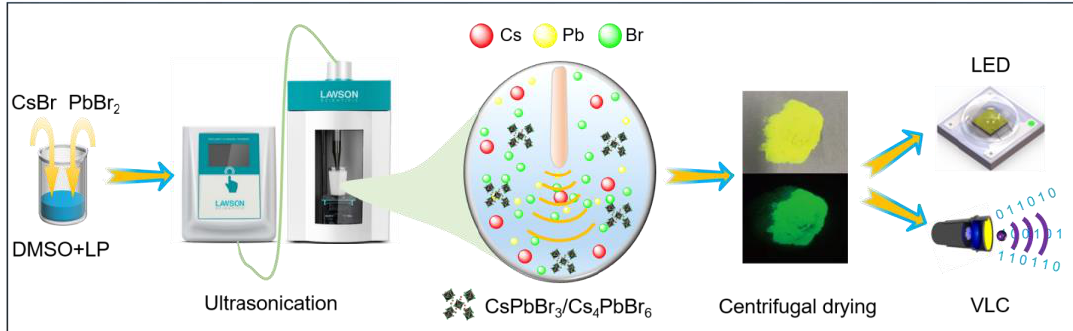
Figure 1. The procedures for the preparation of CsPbBr 3 /Cs 4 PbBr 6 microcrystal using an ultrasonic processor at room temperature and their application in white-light-emitting diodes and visible light communication.